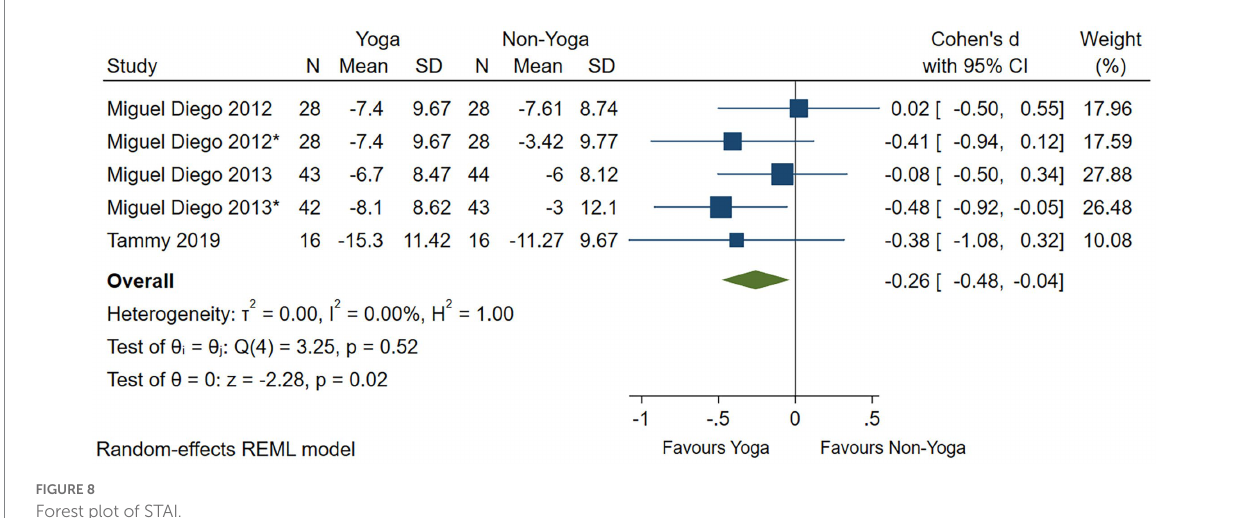
FIGURE 8 Forest plot of